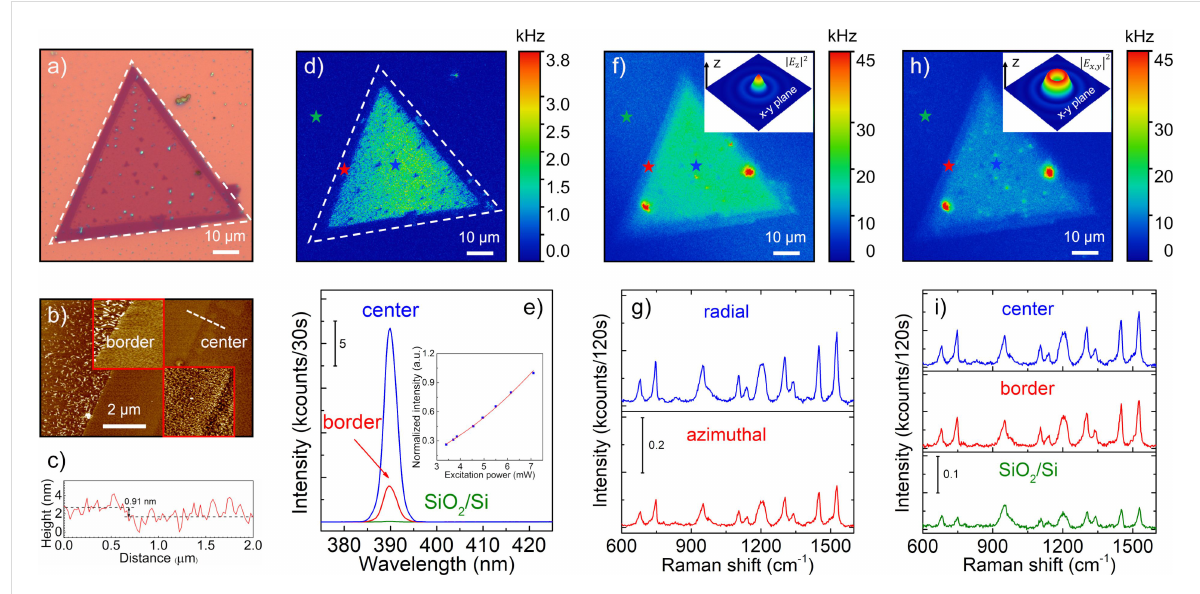
Figure 1: Optical properties of a triangular MoSe 2 flake covered with a thin film of 5 nm of CuPc. (a) Bright-field optical image of CuPc/MoSe 2 . (b) AFM topographic image of CuPc/MoSe 2 . The upper and lower insets show high-resolution AFM images (2 × 2 μ m) scanned from the SiO 2 /Si sub- strate to the border of MoSe 2 flake and from the border to the center of MoSe 2 flake, respectively. The dashed white line represents the position where the height profile was taken. (c) Height profile of CuPc/MoSe 2 . (d) SHG map of CuPc/MoSe 2 . The dashed white triangle denotes the real size of the triangular MoSe 2 flake. SHG measurements were performed using a custom-built confocal microscope with a femtosecond pulsed laser (89.8 fs, 40 MHz, 780 nm, linear polarization). The excitation power used in the SHG map in (d) is 5.80 mW. (e) SHG spectra collected from CuPc/MoSe 2 . The inset shows the integrated SHG intensity as a function of the excitation power. (f) and (h) show optical images of CuPc/MoSe 2 under the excitation of a radial and an azimuthally polarized laser beam, respectively. The optical measurements are performed using a custom-built confocal microscope with a 636 nm diode laser. Raman and photoluminescence spectra are collected simultaneously in the optical images. The blue, red, and green stars indicate the positions where the optical spectra are collected at the center of the MoSe 2 flake, the border of the MoSe 2 flake, and the SiO 2 /Si substrate, respectively. The insets in (f) and (h) show the diagrams of electric field intensity distribution in the x – y plane in the focus of a radially and an azimuthally polarized laser beam (636 nm, continuous wave), respectively. The excitation powers of radially and azimuthally polarized beam were 76.0 μ W and 75.0 μ W, respectively. (g) Raman spectra collected from the center position of the CuPc/MoSe 2 flake under the excitation with a radially and an azimuthally polarized laser beam, respectively. (i) Raman spectra measured at the different positions of the CuPc/MoSe 2 flake using azimuthal